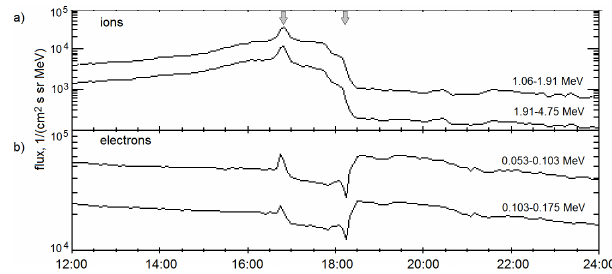
Figure 6. Flux of energetic particles of different energies from ACE EPAM (Advanced Composition Explorer Energetic Proton and Al- pha Monitor), 5min resolution data: (a) ions, (b) electrons. The leading edge of the ICME is indicated by